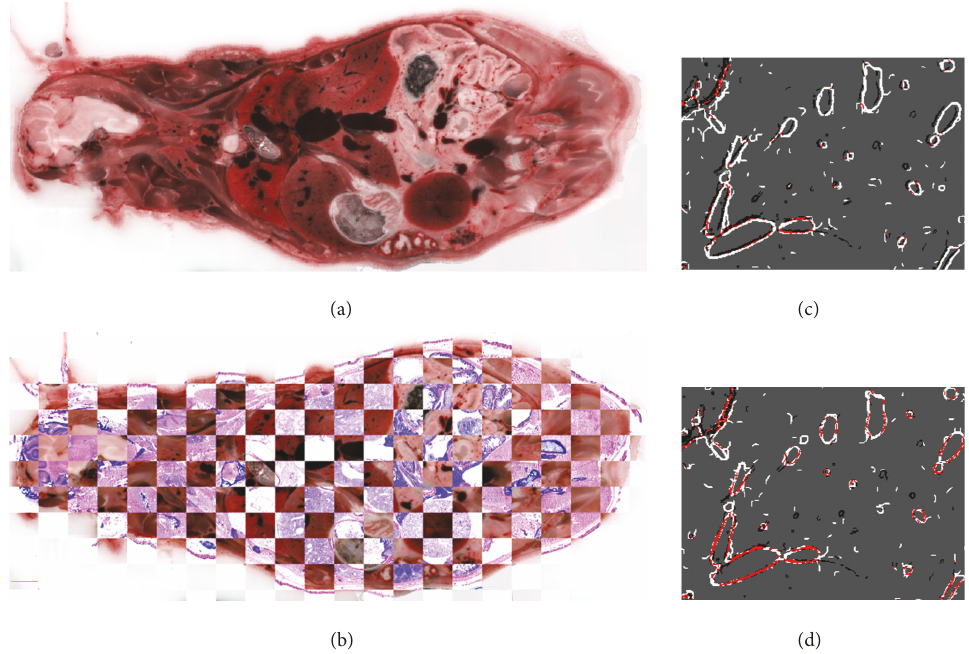
Figure 7: Registration quality of whole mouse histology to color episcopic cryo-image. A whole mouse histological section was obtained with an adhesive film technique and registered to the corresponding color cryo-image (a). A checkerboard display (b) shows that many edges line up in the two registered images. A high resolution checkerboard with 400 𝜇 m on a side was used to roughly estimate registration accuracy by manually measuring distances between edges. Images (c) and (d) show significant edges from cryo-images (black) and histology (white) after affine (c) and nonrigid (d) registration. Pixels colored red indicate an overlay of both black and white edges. The amount of red pixels indicates excellent overlap of edges and improvement with nonrigid registration. Bar is 2750 𝜇 m.